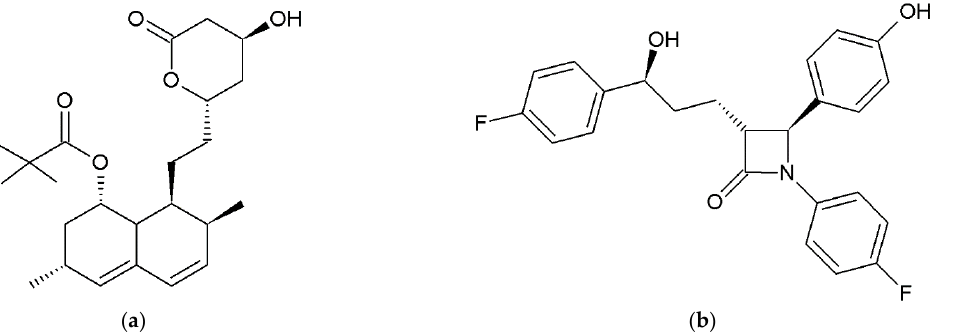
Figure 1. Chemical structures of simvastatin ( a ) and ezetimibe ( b ).